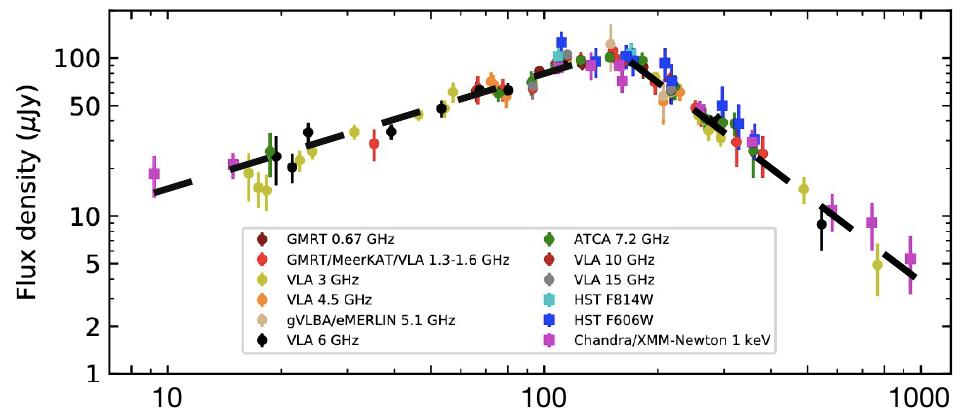
Figure 35. Adapted from Figure 2 of [188]. The radio light curve of SHB170817A, measured until 940 days post-merger, spanning multiple frequencies, and scaled to 3 GHz using the spectral index − 0.584. The early-time trend expected in the CB model is the rising black-dashed line. The late-time trend, also black-dashed, is for an assumed 1/ r 2 ISM density